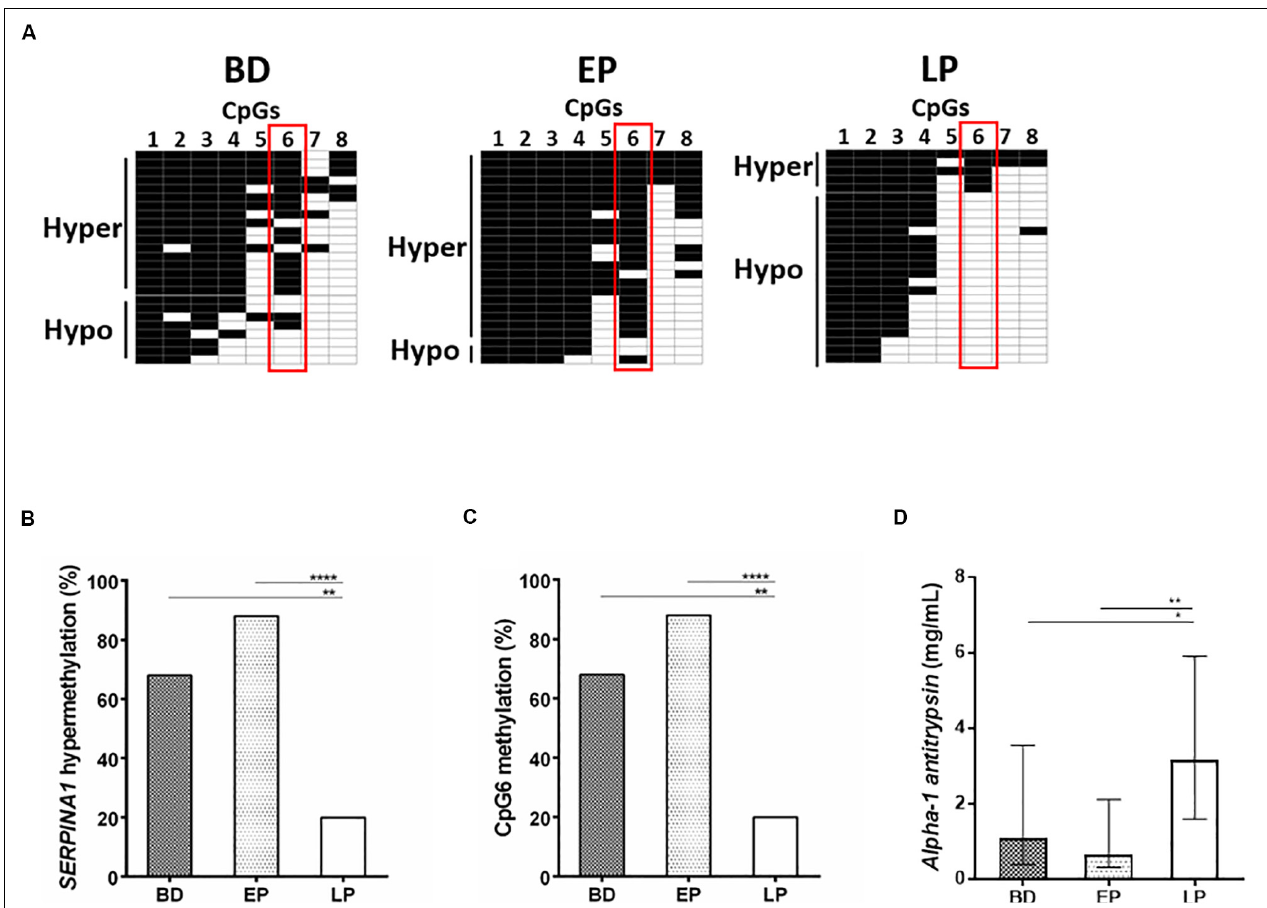
FIGURE 2 | SERPINA1 gene promoter methylation analysis in healthy subjects (HS), including blood donors (BD) and pregnant women at early (EP), and late pregnancy (LP), and serum AAT levels determination in BD, EP, and LP. (A) BD ( N = 25), EP ( N = 25), and LP ( N = 25) stratification according to the number of CpGs methylated (from top to bottom) in SERPINA1 gene promoter, i.e., hypermethylation and hypomethylation. Black boxes represent CpG methylation and white boxes CpG unmethylation. The CpGs within the SERPINA1 promoter are numbered across the top of the grid. Each row represents one sample analyzed by sequencing. Vertical red boxes highlight CpG6 across hypermethylated and hypomethylated samples. Samples were considered hypermethylated when ≥ 5/8 CpGs ( ≥ 50%) were methylated. (B) Frequency of SERPINA1 gene promoter hypermethylation in BD ( N = 25), EP ( N = 25), and LP ( N = 25). ** p < 0.01, **** p < 0.0001. (C) Frequency of CpG6 methylation BD ( n = 25), EP ( n = 25), and LP ( n = 25). ** p < 0.01, **** p < 0.0001. (D) Median (interquartile range [IQR]) AAT concentration in serum samples from BD ( n = 25), EP ( n = 25), and LP ( n = 25). The AAT concentration in sera is reported as mg/mL. Concentrations were determined by ELISA test. * p < 0.05, ** p <